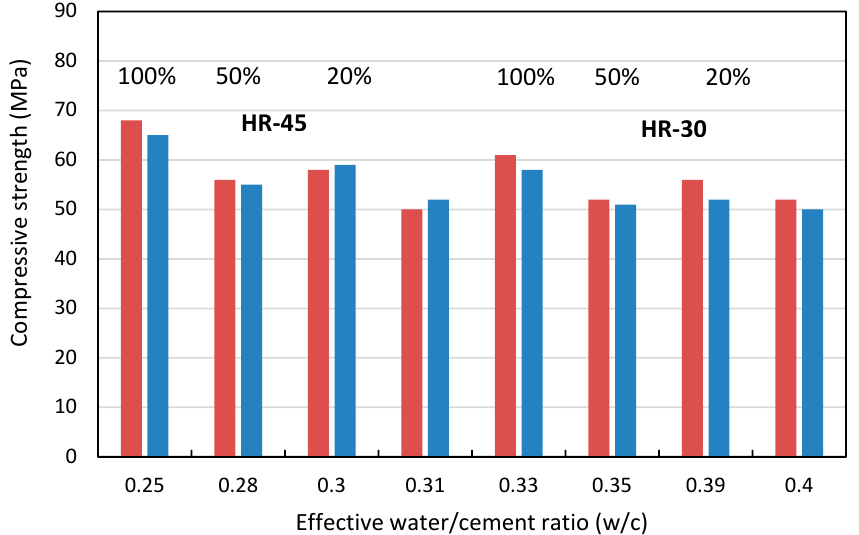
Figure 11. Comparison of compressive strength results after thermal shock cycles ( blue ) with the reference ( red ) specimens as a function of their effective w/c ratio.